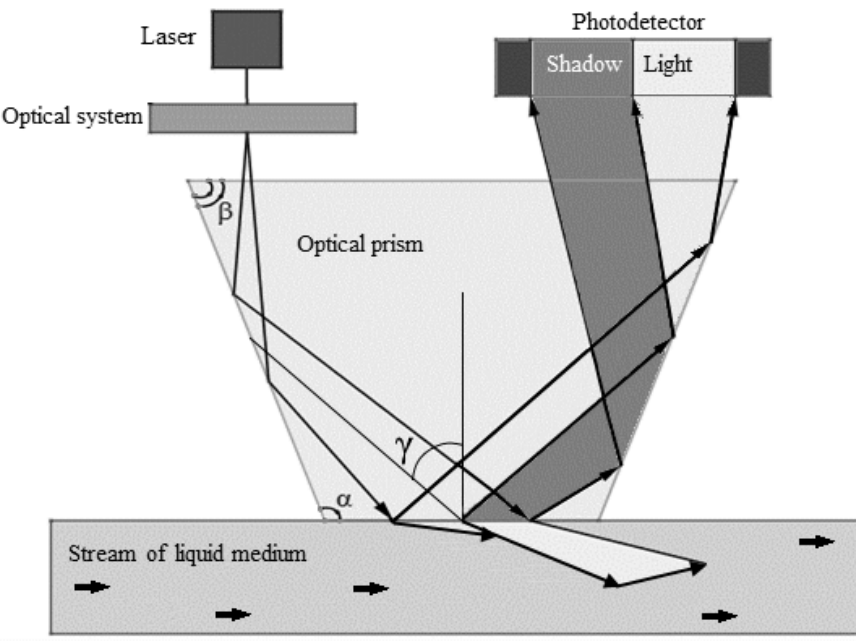
Figure 1. Structural diagram of the optical part of a